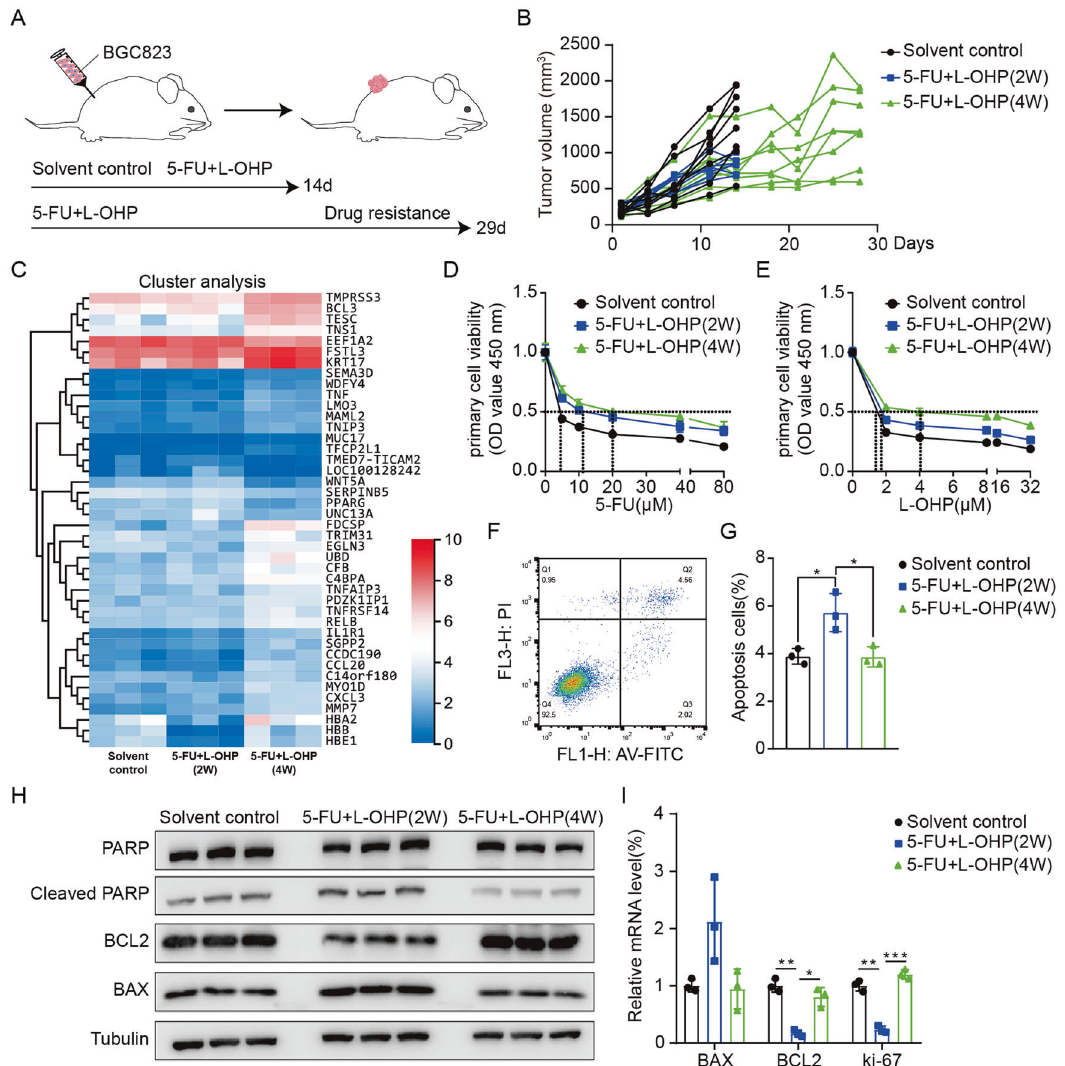
Fig. 1 First-line chemotherapy effectively inhibits GC growth but develops drug resistance. A Schematic representation of the BGC823- bearing model of fi rst-line chemotherapy resistance. B The growth curves of tumor ( n = 8 per group). C Hierarchical clustering gene transcription altered at different periods of chemotherapy. D , E The half-maximal inhibitory concentration (IC50) was measured by CCK8 assay. Primary cells from dissected tumor tissues were treated with different concentrations of 5-Fu (0, 5, 10, 20, 40, and 80 μ M) and oxaliplatin (0, 2, 4, 8, 16 and 32 μ M). F , G Flow cytometric assay of primary cells from dissected tumor tissues. Data are mean ± standard deviation. * P < 0.05. H Protein expression of apoptosis-related proteins (PARP, cleaved PARP, Bcl2, and Bax) were detected by western blot analysis in dissected tumor tissues. I The mRNA expression of Bax, Bcl2, and ki-67 in dissected tumor tissues were detected by qRT-PCR assay. Data are mean ± standard deviation. * P < 0.05, ** P < 0.01, *** P <